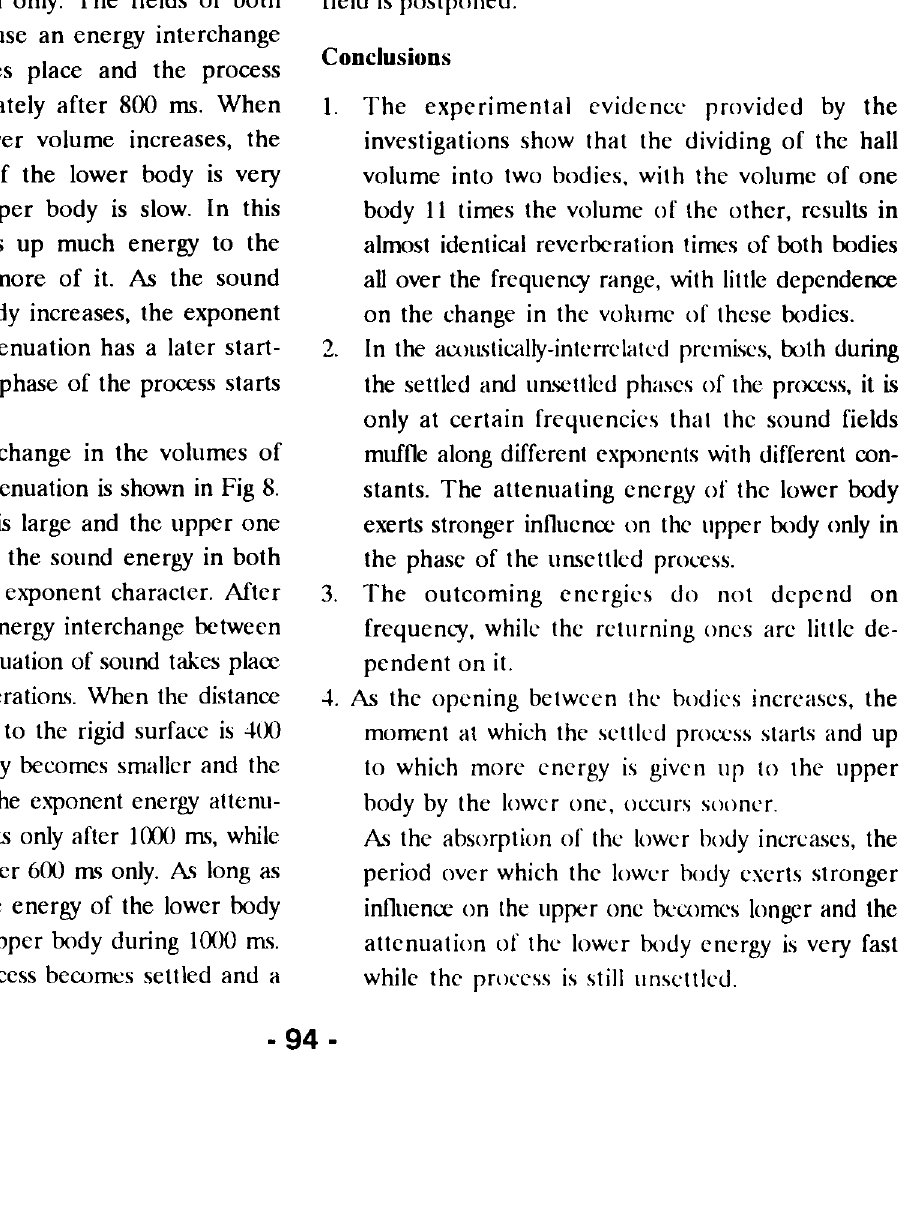
Fig 7. The dependence of the attenuation of the sound energy on the change in the sound absorption in the lower body V 1. 1 and 2 - the lower body V V 2, when a 1 = 0.3; 3 and 4 - same with a 1 = 0.1 When the absorption of the lower body is small,